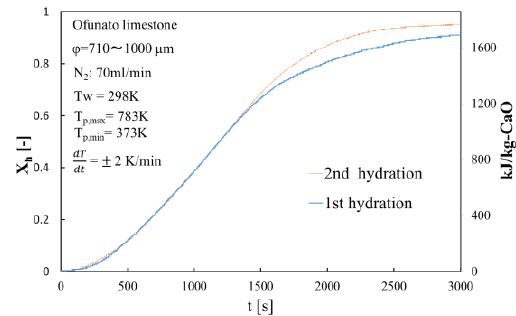
Figure 9. Hydration conversion of Ofunato CaO after decarbonization at 1223 K in TGA-51.